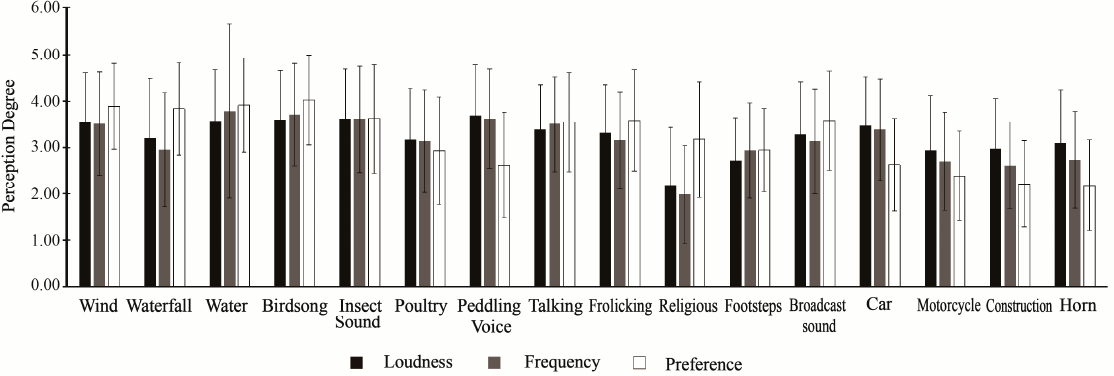
Figure 3. Assessment of typical soundscape perception.